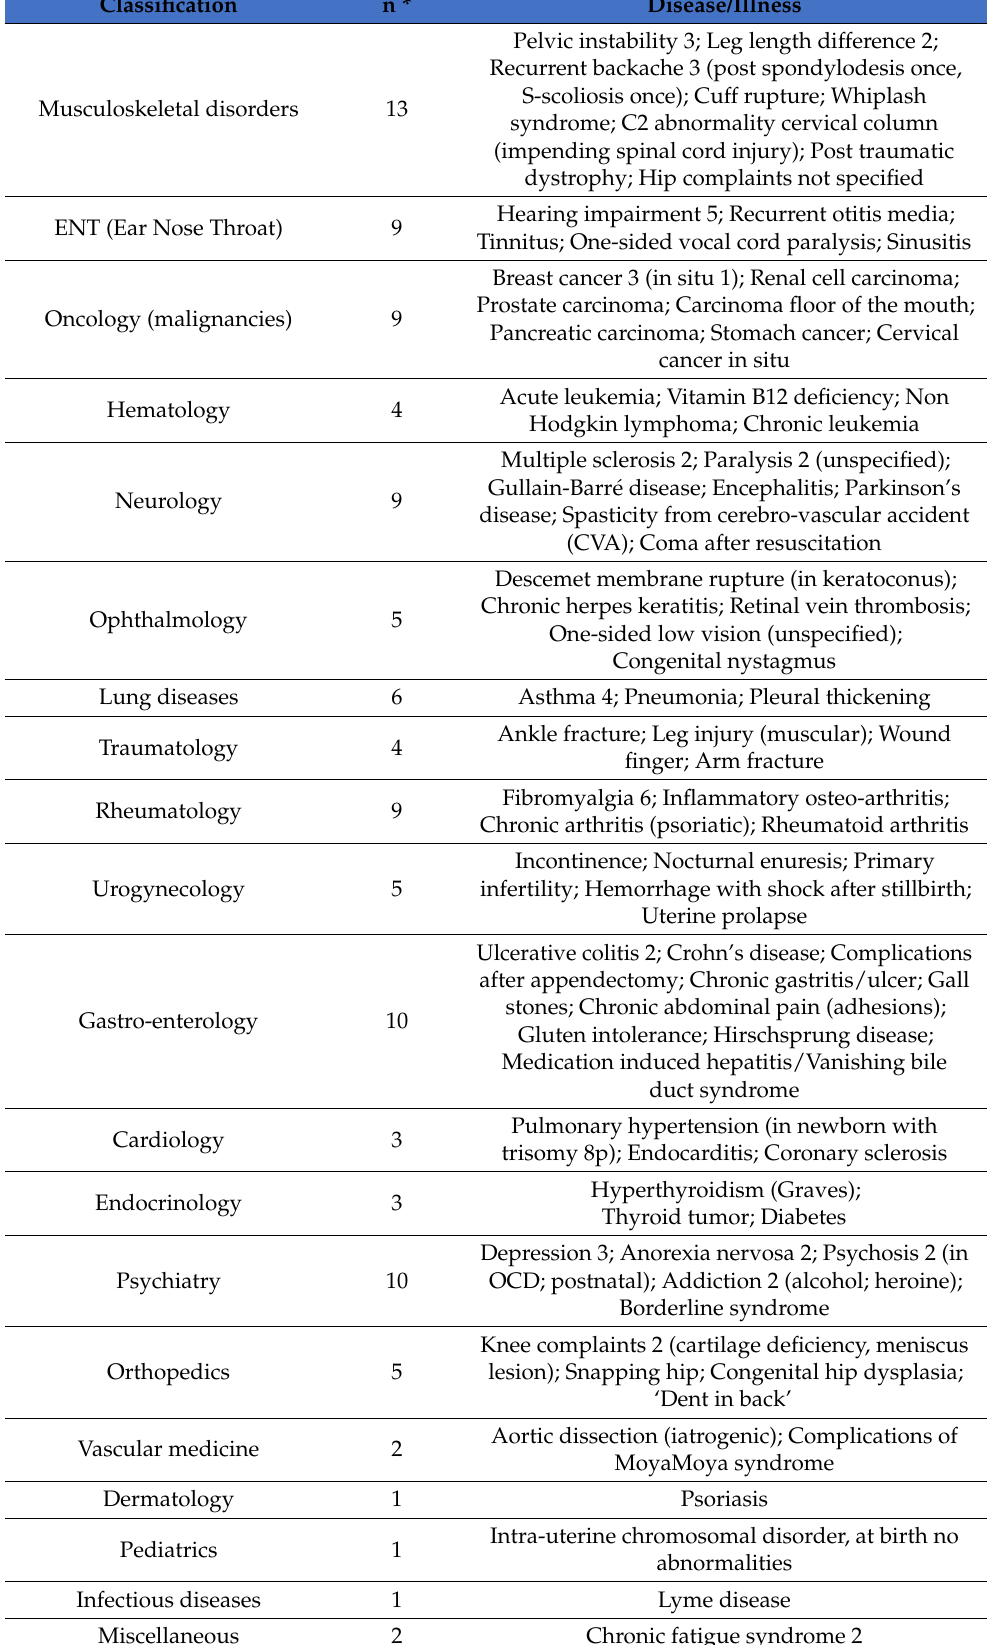
Table 5. Spectrum of diseases reported (n > 83 as some report > 1 healed illness).